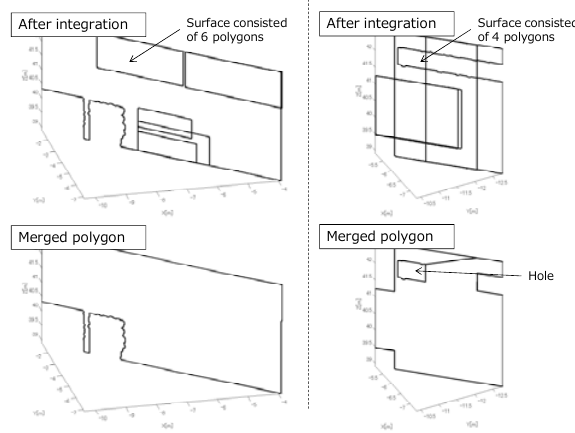
Figure 15. Results of 3D polygon Boolean